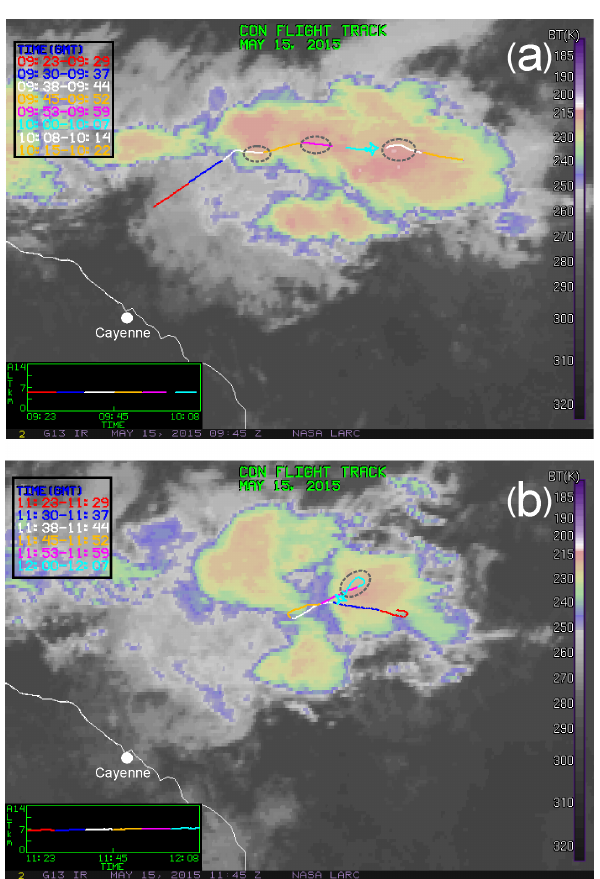
Figure 4. GOES-13 infrared image of the MCS with the Con- vair 580 track (courtesy of Pat Minnis) corresponding to time seg- ments shown in Figs. 5 and 8. Circles indicate the cloud regions along the flight track where SIP was identified (see Fig. 5). The marked regions also coincide with convective cloud regions (see